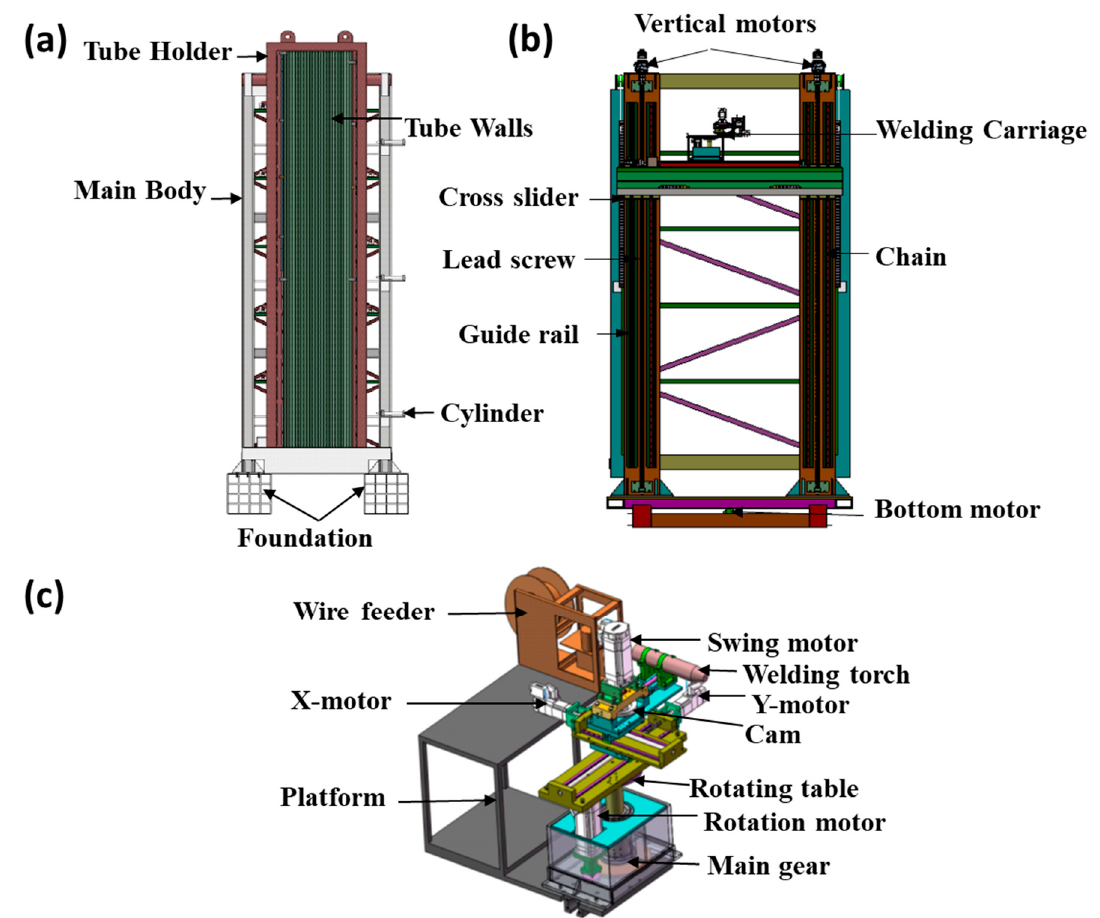
Figure 2. The mechanical structures and components of the proposed system. ( a ) Headframe; ( b ) gantry; ( c ) welding carriage.